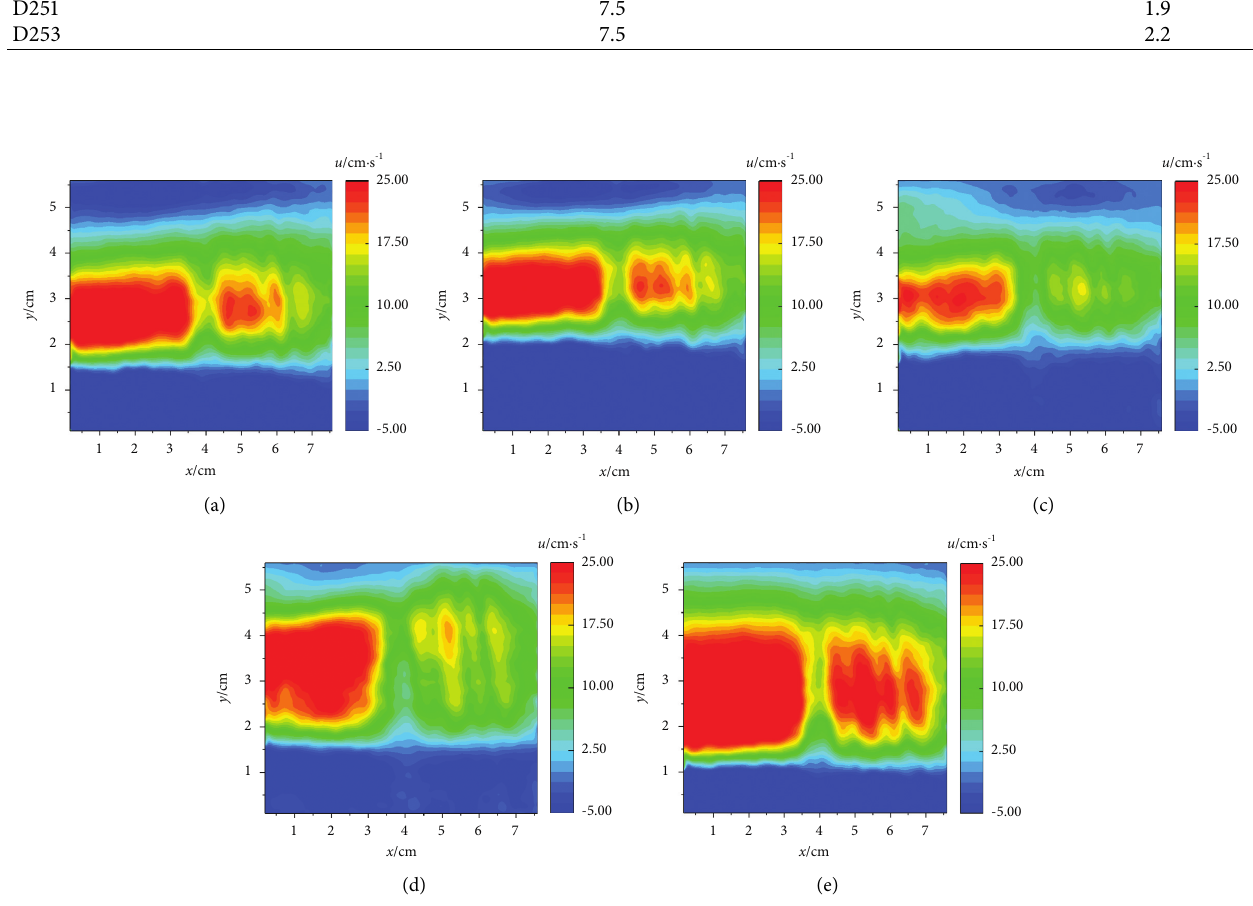
Figure 3: The distribution of the time-averaged longitudinal velocity in different working conditions. (a) H25-1, (b) H25-1.2, (c) H25-1.5 (D252), (d) D251, and (e)